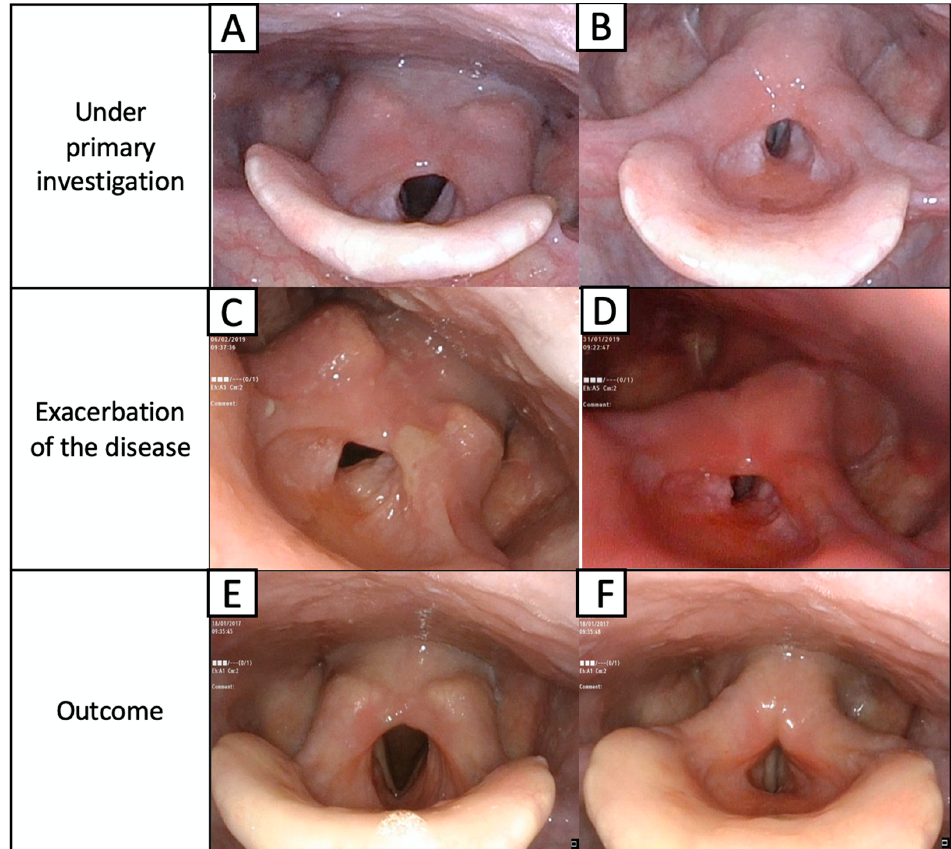
Figure 2. Laryngeal concentric stenosis of epiglottic area is mostly seen as an overgrowth of both the aryepiglottic folds and the posterior part of the larynx above the unchanged vocal folds. Mobility of the vocal folds is slightly limited by the supraglottic narrowing, which significantly reduces the larynx patency. Vocal folds are seen in the respiratory ( A ) and phonation phases ( B ). During the exacerbation of the disease, massive swelling of the supraglottic region and the progress of stenosis ( C , D ) are visible. The condition after 6 months of treatment from worsening of the disease, visible regression of the disease in the larynx during respiratory ( E ) and phonation phases ( F ).